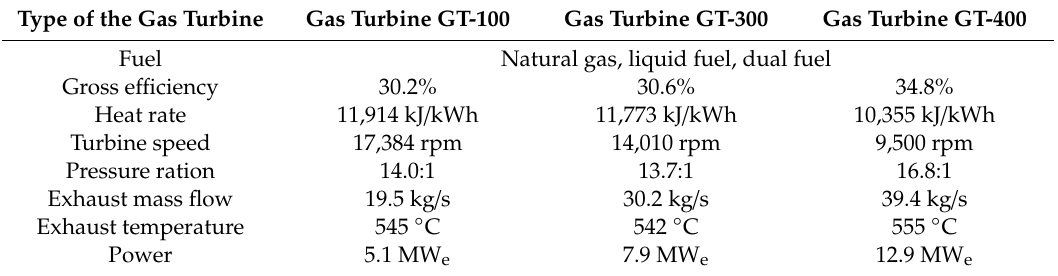
Table 3. Comparison of the basic technical parameters of the GT-100, GT-300 and GT-400 gas turbines. Source: Own study based on